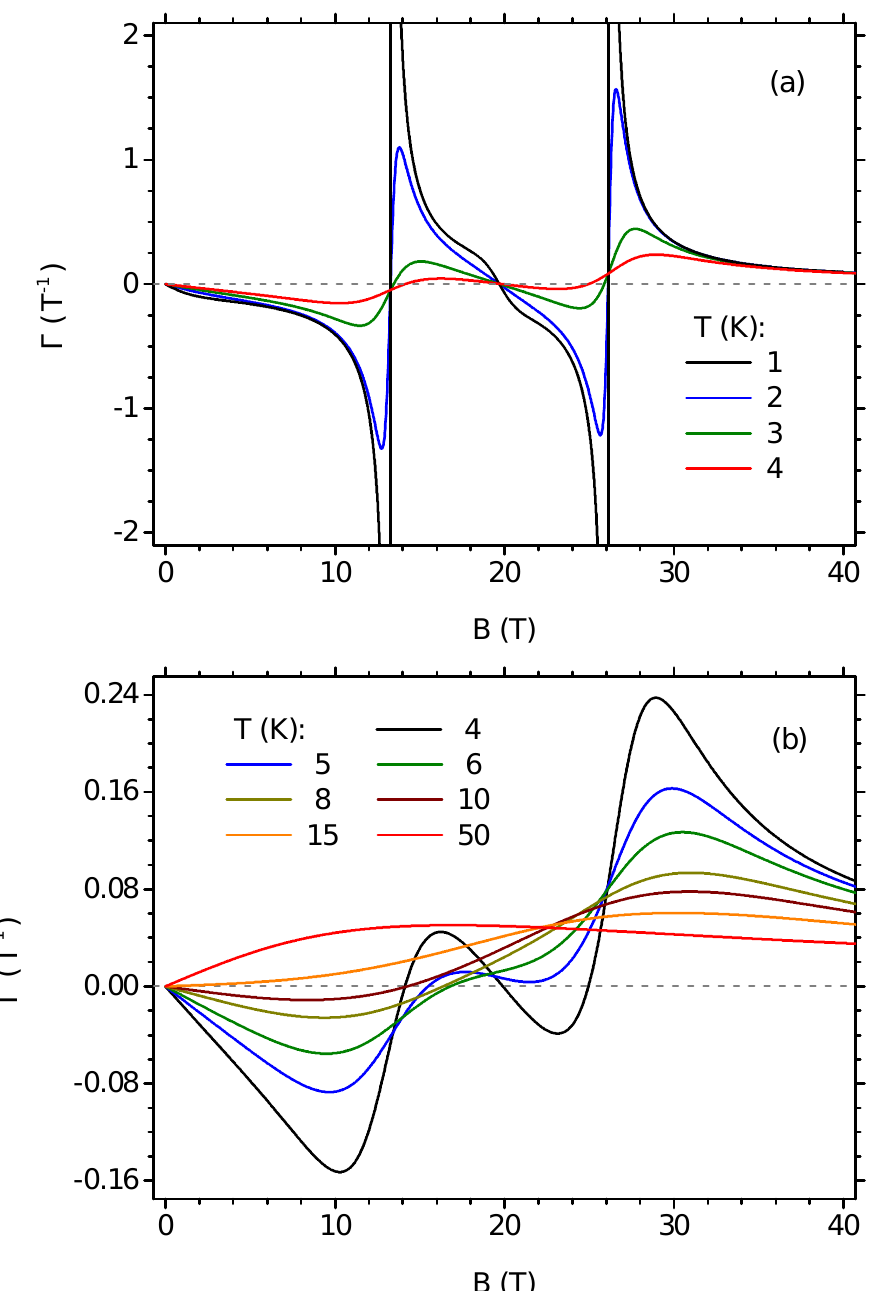
Figure 12. The dependence of the magnetic Grüneisen ratio on the initial value of the external magnetic field in the isothermal process (the final value of the magnetic field is zero), for selected temperatures. ( a ) low-temperature range; ( b ) higher temperature